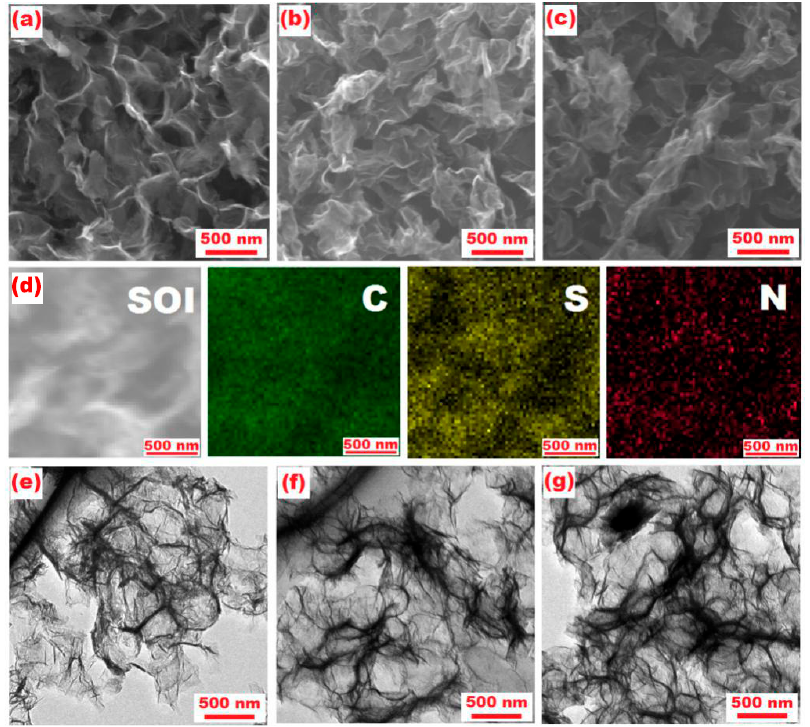
Figure 4. SEM images of ( a ) PG, ( b ) PPy/PG, and ( c ) S/PPy/PG; SEM image of ( d ) S/PPy/PG and corresponding elemental mapping of carbon (C), sulfur (S) and nitrogen (N); TEM images of ( e ) PG, ( f ) PPy/PG and ( g ) S/PPy/PG composite.